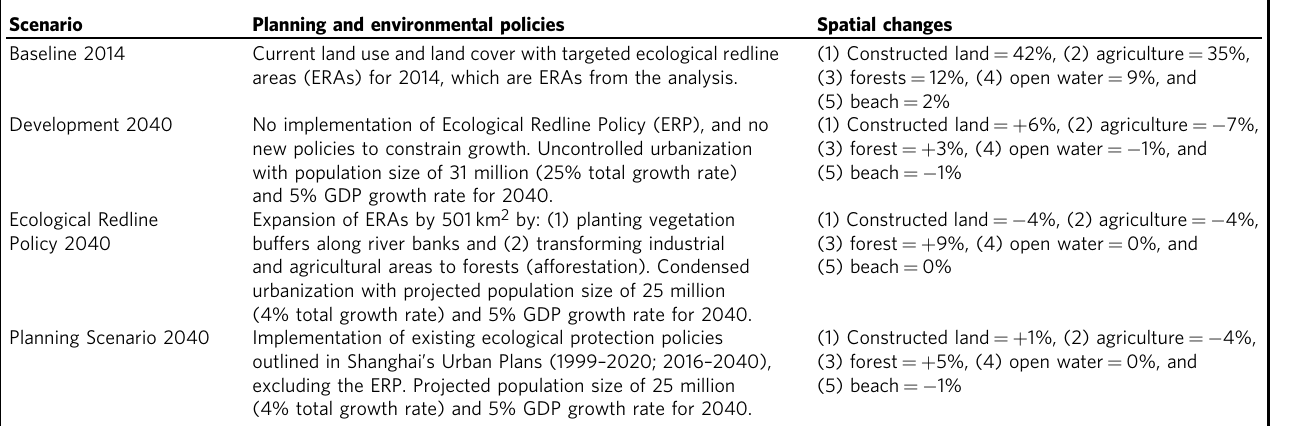
Table 2 Development policies describing urbanization rates and spatial form based on various urban planning policies Scenario